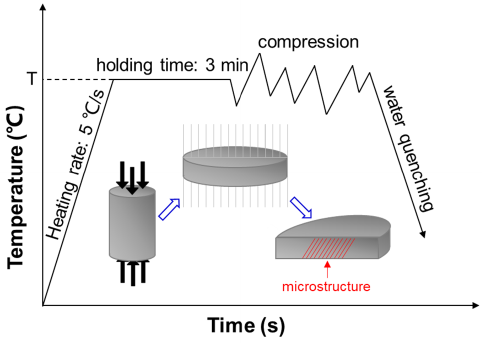
Figure 2. Sampling method for hot